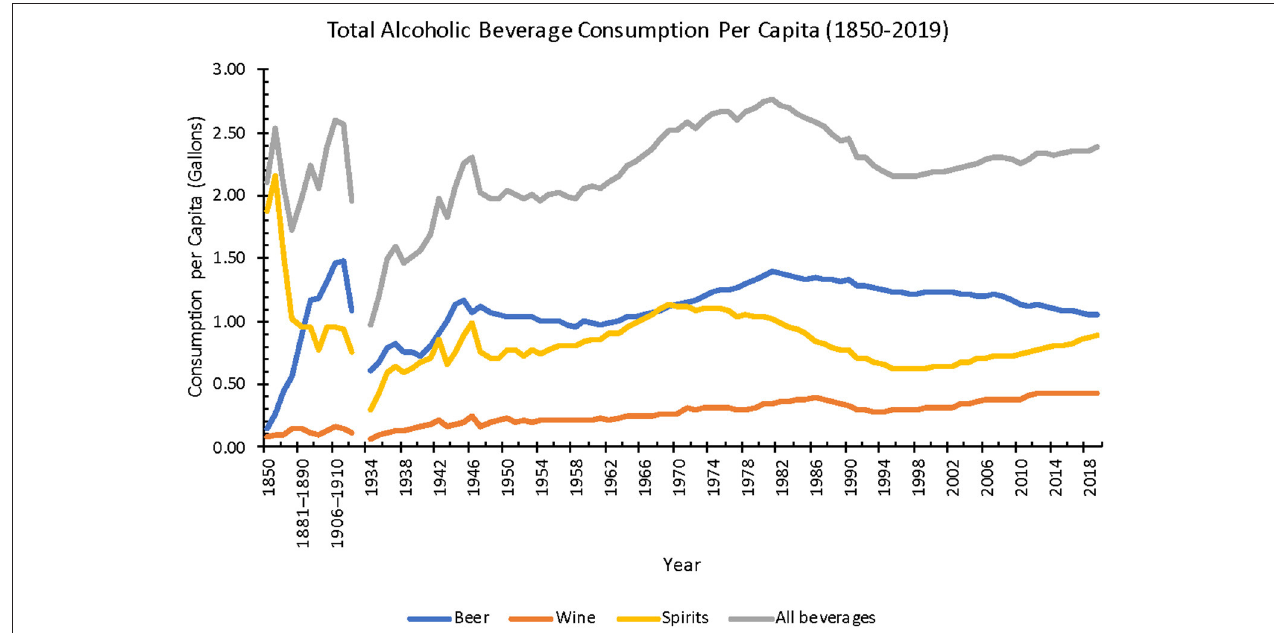
FIGURE 9 | Annual total alcoholic beverage consumption per capita from 1850 to 2019 (Source: NIAAA ). The gap in data is due to Prohibition from 1920 to 1933.